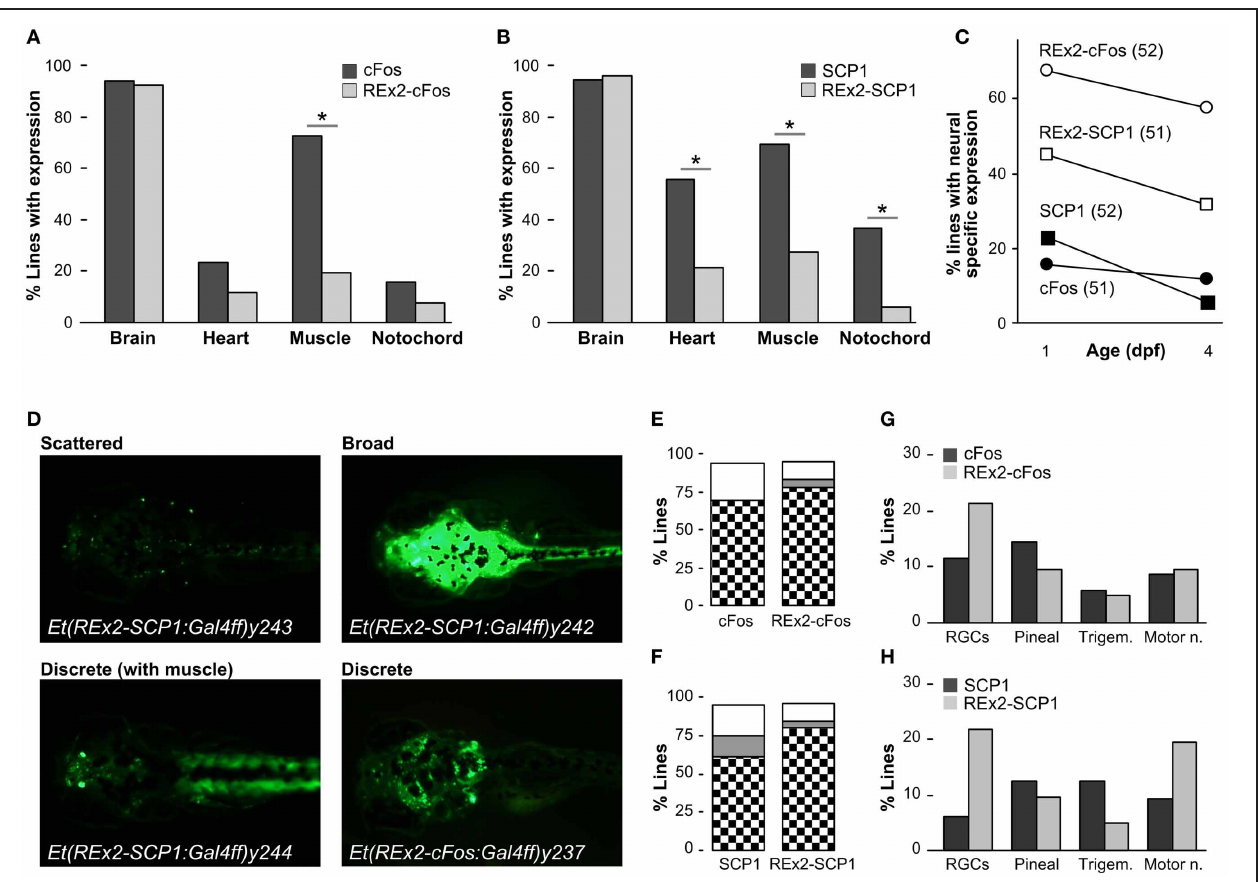
brain. Lines were crossed to Tg(UAS:Kaede)s1999t for visualizing expression. (E) and (F) show the percentage of lines with expression in discrete brain structures (checks), broad expression through the brain (gray) or stochastic asymmetric expression in the brain (white) for the indicated enhancer trap constructs. (G) Percentage of lines with expression in the indicated neuronal cell types at 4dpf for enhancer trap lines generated using the cFos:Gal4ff (dark bars) and REx2-cFos:Gal4ff (light bars) constructs. (H) As for (G) but with SCP1:Gal4ff (dark bars) and REx2-SCP1:Gal4ff (light bars). ∗ p < 0 . 001 for all